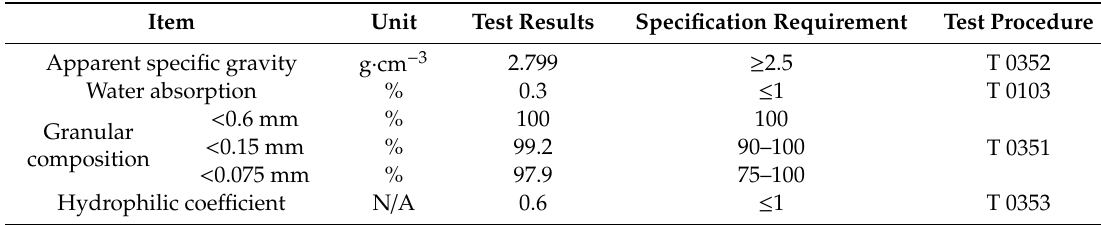
Table 5. Technical parameters of mineral powder.